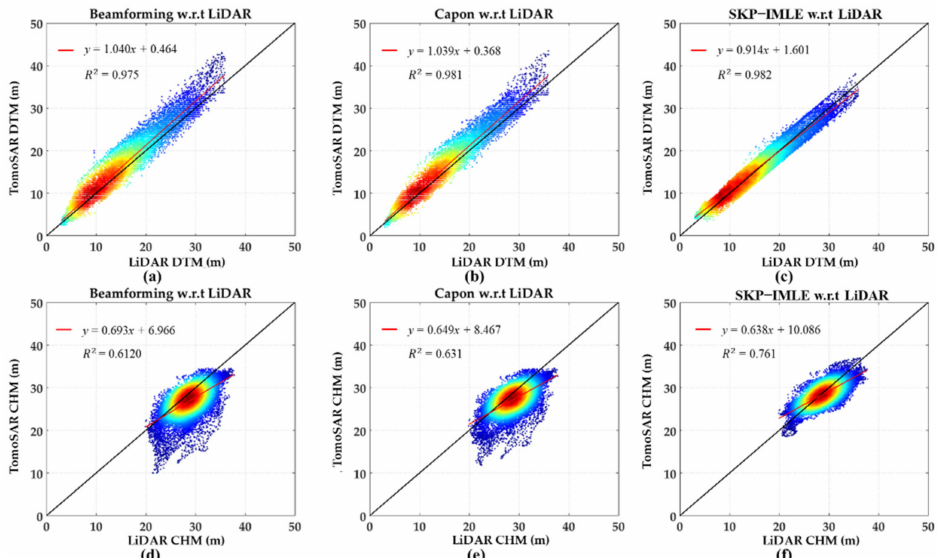
Figure 11. The relationships between the LiDAR and TomoSAR heights in ROI1: ( a ) LiDAR-based DTM and underlying topography by the Pol-beamforming method; ( b ) LiDAR-based DTM and underlying topography by the Pol-Capon method; ( c ) LiDAR-based DTM and underlying topography by the SKP-IMLE method; ( d ) LiDAR-based CHM and forest height by the Pol-beamforming method; ( e ) LiDAR-based CHM and forest height by the Pol-Capon method; ( f ) LiDAR-based CHM and forest height by the SKP-IMLE method.